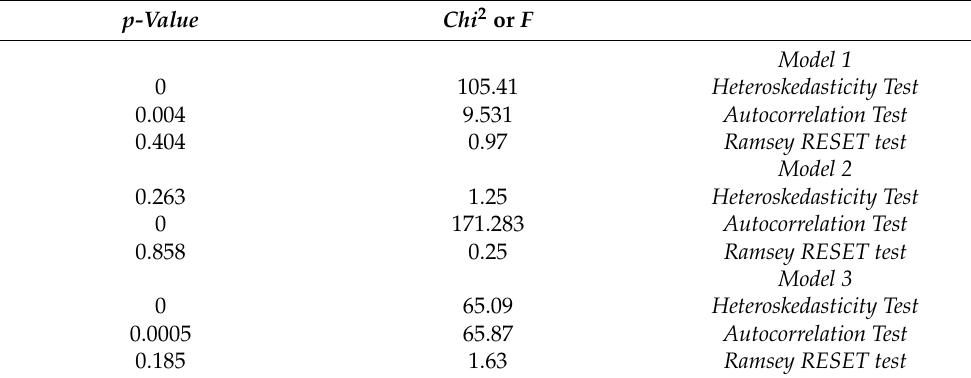
Table 8. The results of the tests after estimating the regressions.